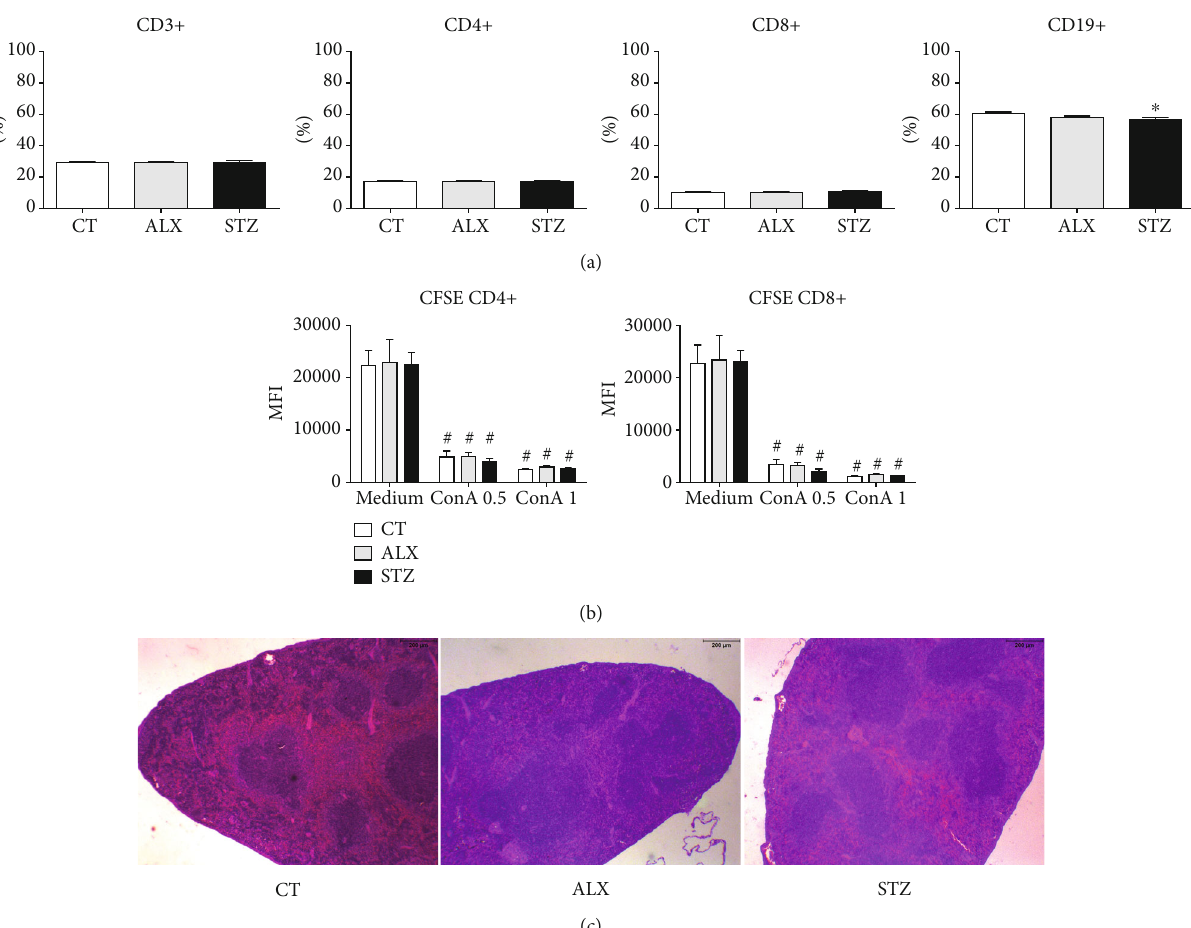
Figure 5: STZ has short-term diabetogenic impact on the population of B lymphocytes in the spleen. T1D was induced as described in Methods, and (a) spleens from the CT, ALX-, and STZ-treated groups were collected on the 15 th day, and the total spleen cells were characterized according to the cell surface markers CD3, CD4, CD8, and CD19 by fl ow cytometry. (b) Spleen cells from each group were also stained with CFSE, incubated with medium, Con A (0.5 and 1 μ g/mL — fi nal concentration), for 72 hours, and had T cell proliferation evaluated by fl ow cytometry. (c) Representative microphotographs of 3 μ m sections of spleen tissue stained with H&E (scale 200 μ m). Data are presented as mean ± SEM , ∗ p ≤ 0 : 05 , and # p < 0 : 05 versus respective control medium (6-13 animals per